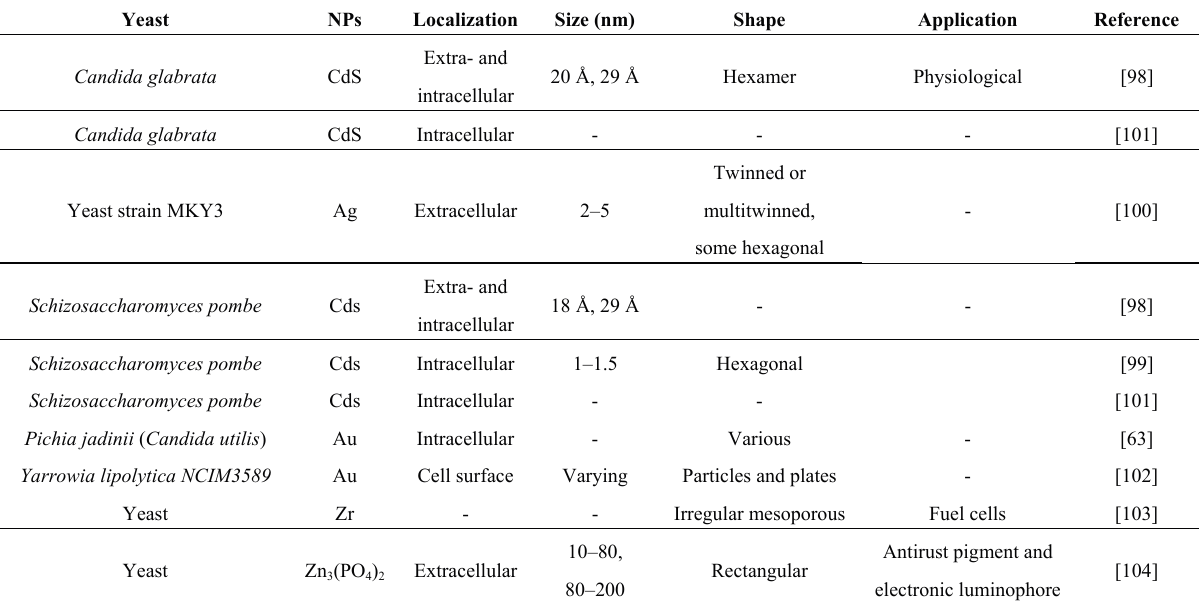
Table 3. Nanoparticle synthesis by